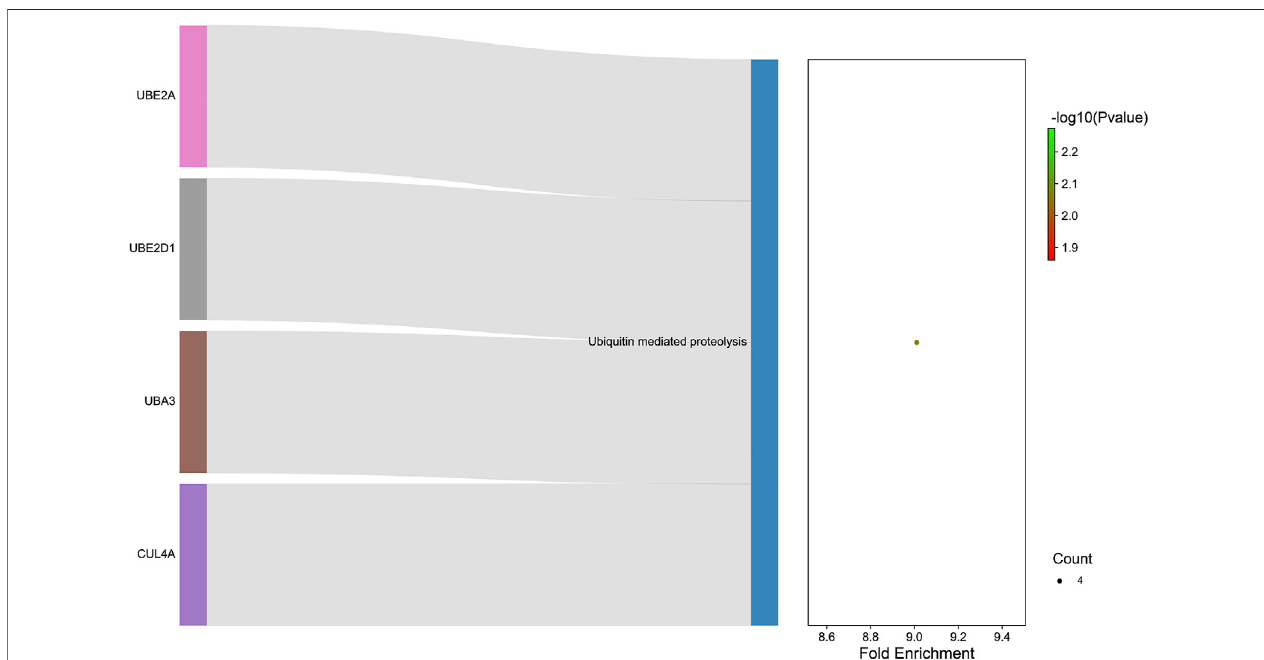
FIGURE 8 | :The KEGG enrichment analysis of down-regulated genes. The y -axis and x -axis depict KEGG-enriched terms and the Gene Ratio, respectively. The size of thedot means the number ofgenes and the color ofthe dots represents the p -value. The left cluster plot shows achord dendrogramof clustering the expression spectrum of signi fi cantly DE genes. DE, differentially expressed; KEGG, Kyoto Encyclopedia of Genes and Genomes.